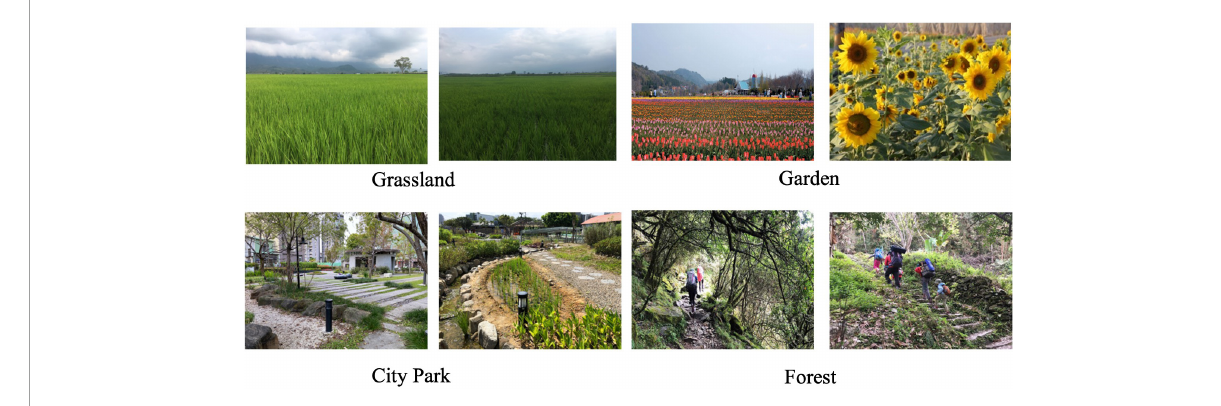
FIGURE1 The image provided by research fellows in photo-elicitation interview procedure.